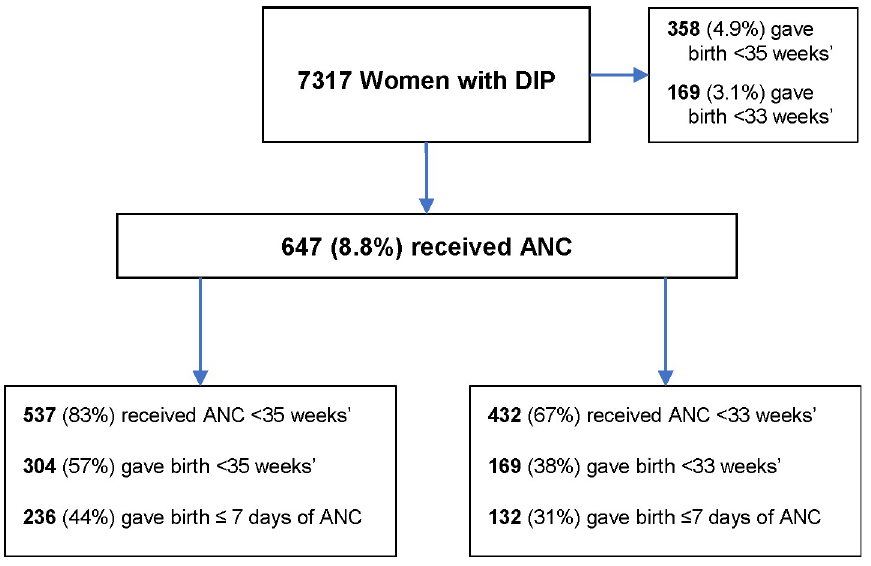
Fig 1. The relationship between the gestational age at ANC administration and birth. ANC–Antenatal corticosteroids, DIP–Diabetes in pregnancy.